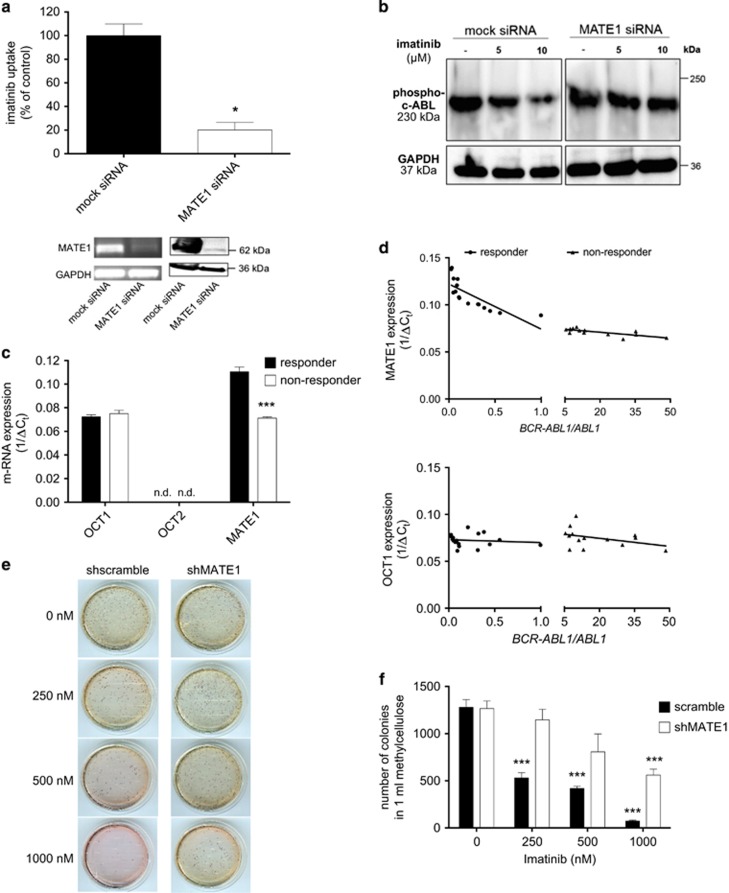
MATE1 mediates imatinib uptake in target cells and MATE1 expression levels correlate with sensitivity of CML patients to imatinib. (a) MATE1 knockdown in K562 cells with specific siRNA reduces the imatinib uptake compared with mock siRNA-transfected cells detected by HPLC (n=4). MATE1 knockdown was confirmed by RT-PCR and western blot analysis (lower panel). Imatinib was used at 5 μM and unpaired Student's t-test was used for statistical analysis. (b) Concentration-dependent effects of imatinib (5 and 10 μM) on c-ABL phosphorylation in MATE1- and mock siRNA-transfected K562 cells as quantified by western blot analysis in relation to the housekeeping gene GAPDH. (c) MATE1 and OCT1 mRNA expression in relation to the housekeeping gene. (d) OCT expression levels were analyzed in total BM cells of CML patients by qRT-PCR and correlated with the molecular response to imatinib treatment. MATE1 (1/ΔCt=0.11±0.04, P<0.0001 for responders and 1/ΔCt=0.07±0.001 for non-responders, P<0.0001) but not OCT1 (1/ΔCt=0.07±0.002 for responders and 1/ΔCt=0.08±0.003 for non-responders, P=0.4102) expression is lower in imatinib non-responders compared with responders (c) and correlates with the BCR-ABL1/ABL1. Thirty patients with BCR-ABL1 major transcript (p210)-positive CML were included in this study and unpaired Student's t-test was used for statistical analysis. (e and f) MATE1 knockdown in K562 cells with specific siRNA reduces the concentration-dependent effects of imatinib on colony growth compared with shscramble-transduced K562 cells (n=4). Unpaired Student's t-test was used for statistical analysis. *P<0.05; ***P<0.005.